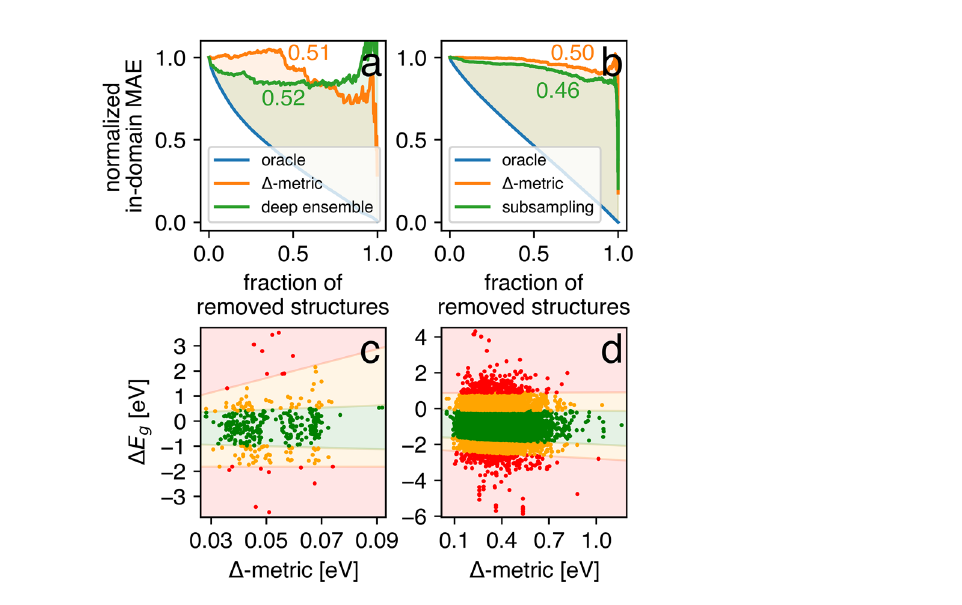
Figure 7. Confidence curves and predictive error as a function of the Δ-metric for the two considered out- of-domain use cases: ( a , c ) SNUMAT-MEGNet → C2DB-GPR-CFID, ( b , d ) QMOF-KRR-ElemStat → OMDB- RF-PLMF. Colored areas in subgraphs ( c ) and ( d ) correspond to the predictive intervals extracted by quantile regression: within one standard deviation (green), within two standard deviations (orange), and over two standard deviations